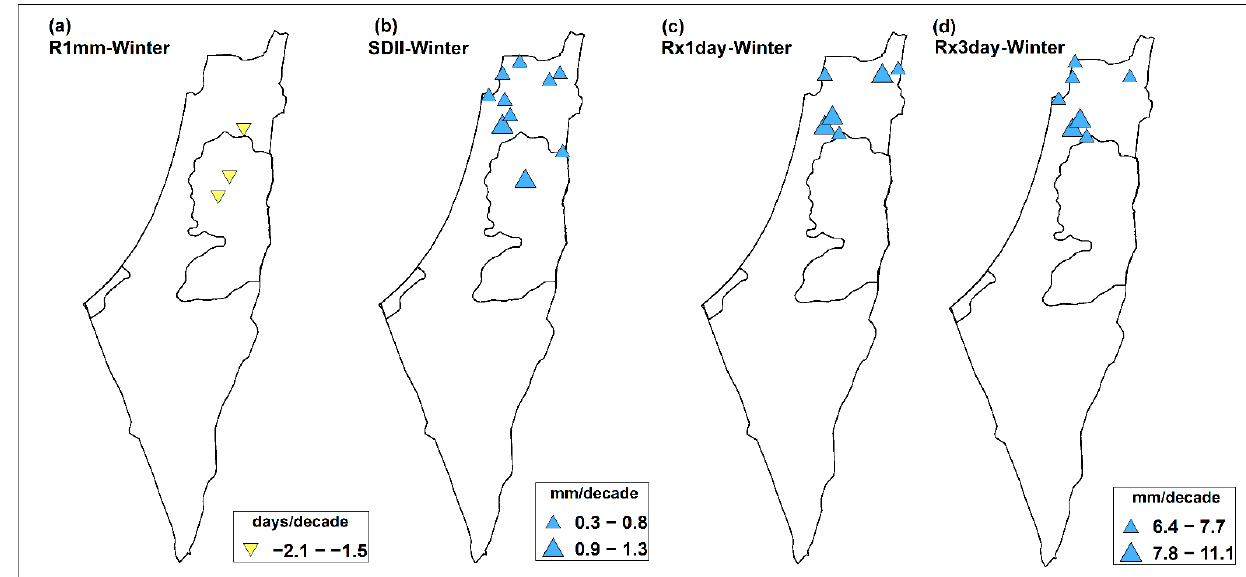
Figure 3. Spatial distribution of winter trends for some indices that exhibited notably significant decreasing (yellow triangles) or increasing (blue triangles) trends. Legend for RX1day and RX3day indices is common.